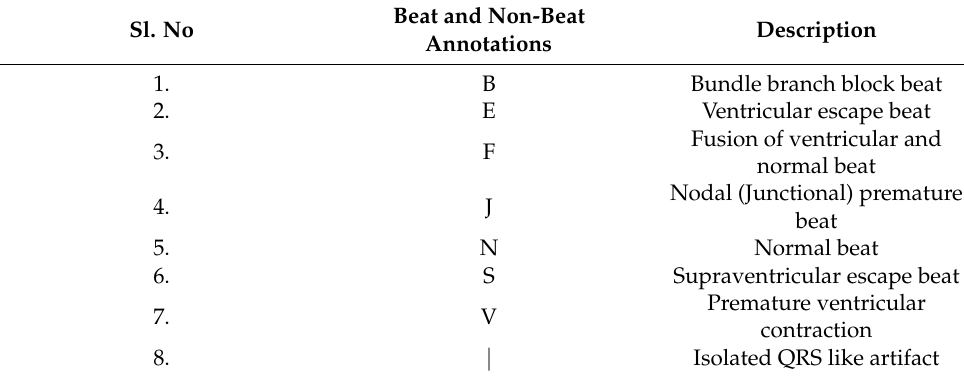
Table 2. Annotations of heartbeats for SCA